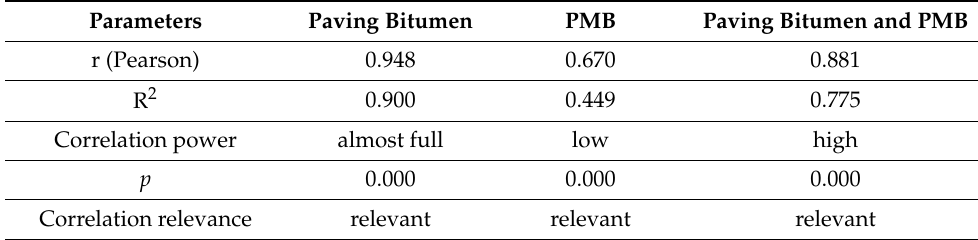
Table 7. Statistical analysis, the correlation of ∆ G* indexes of extracted and original binders.